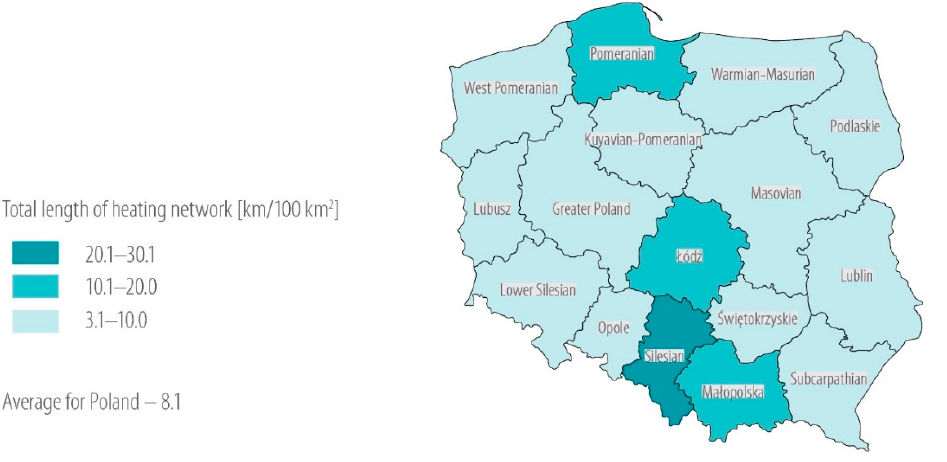
Figure 5. Heat network density in 2017 (based on Reference [25]).